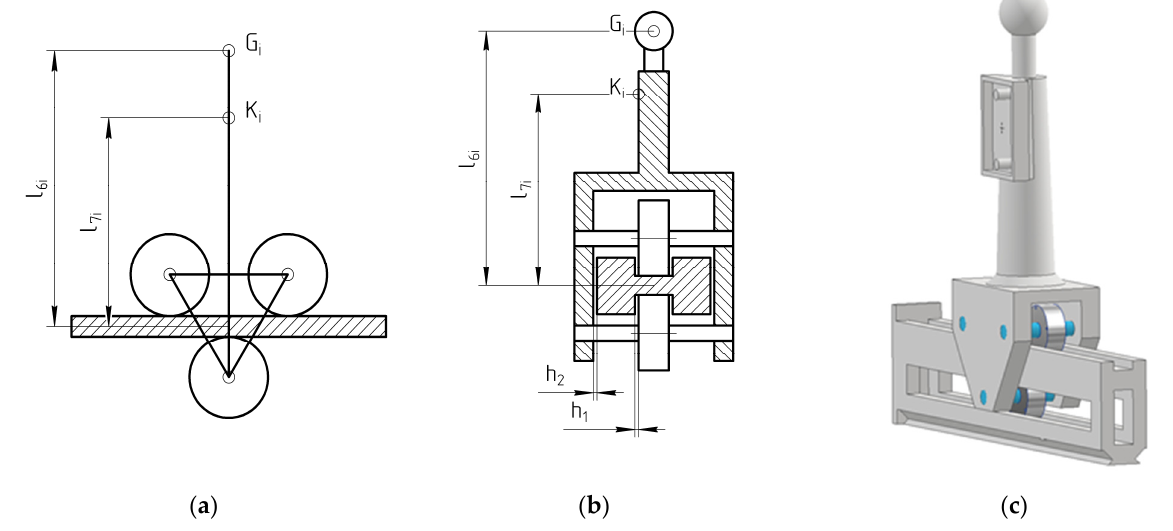
Figure 3. CAD translational joint view: ( a ) scheme, ( b ) structure, and ( c ) CAD design.